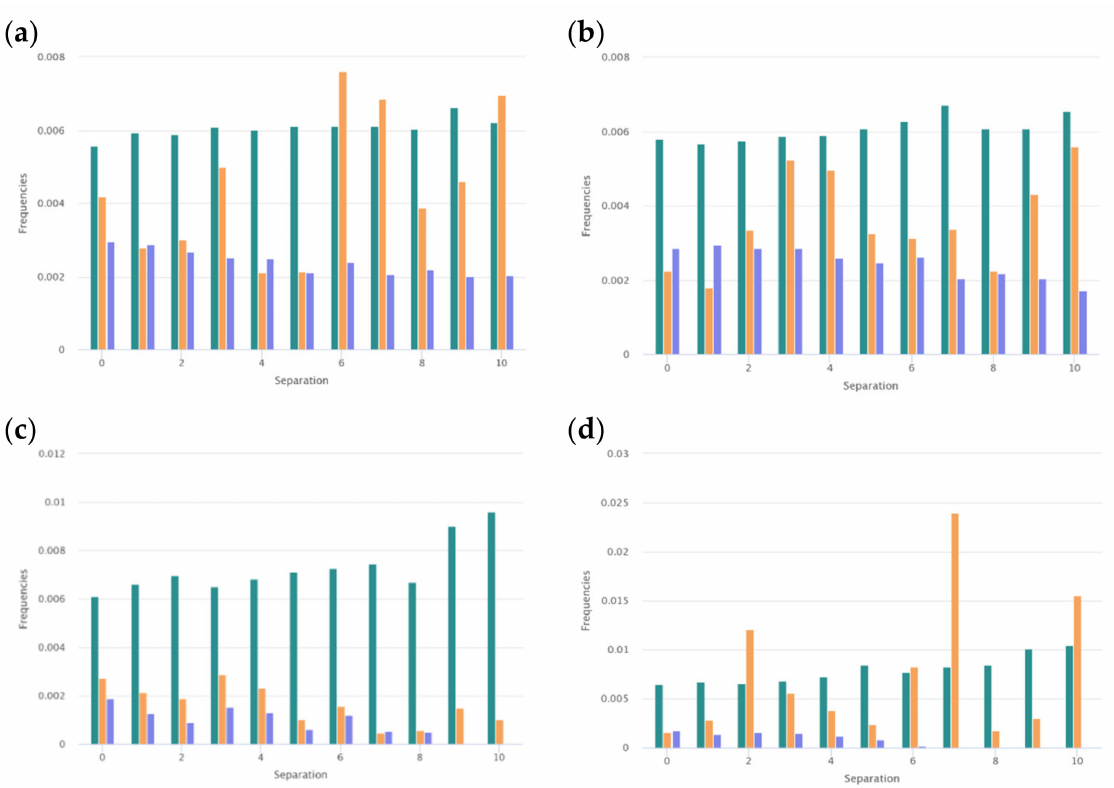
Figure 6. Frequencies of the appearance of pairs of amino acid with the i residues between them, for: ( a ) Gly-Pro in the set of short (17–30 aa) linear ribosomal AMPs; ( b ) Pro-Gly in the set of short (17–30 aa) linear ribosomal AMPs; ( c ) Gly-Pro in the set of very short (10–15 aa) linear ribosomal AMPs; ( d ) Pro-Gly in the set of very short (10–15 aa) linear ribosomal AMPs. The assessments have been performed using the tools of the page of “Statistics” (https://dbaasp.org/statistics, accessed on 20 March 2021) of the DBAASP